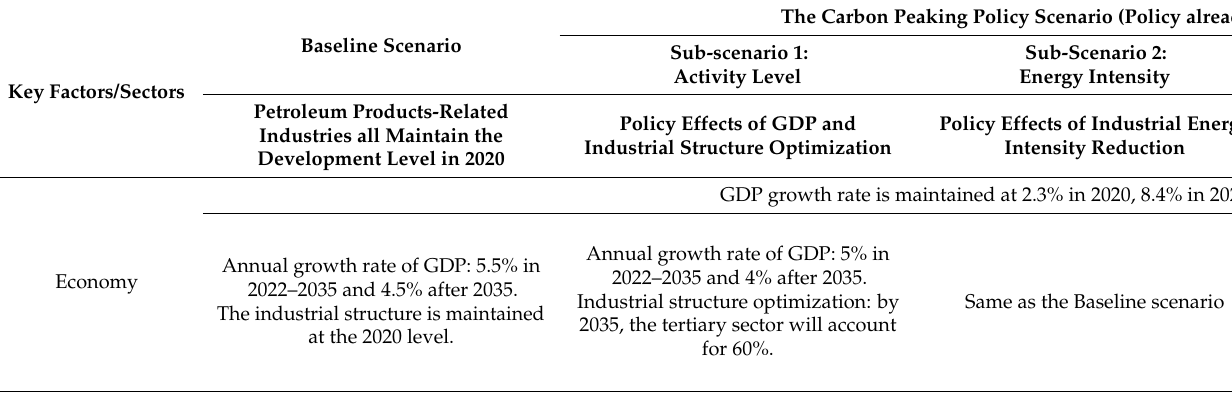
Table 2. Connotations of different